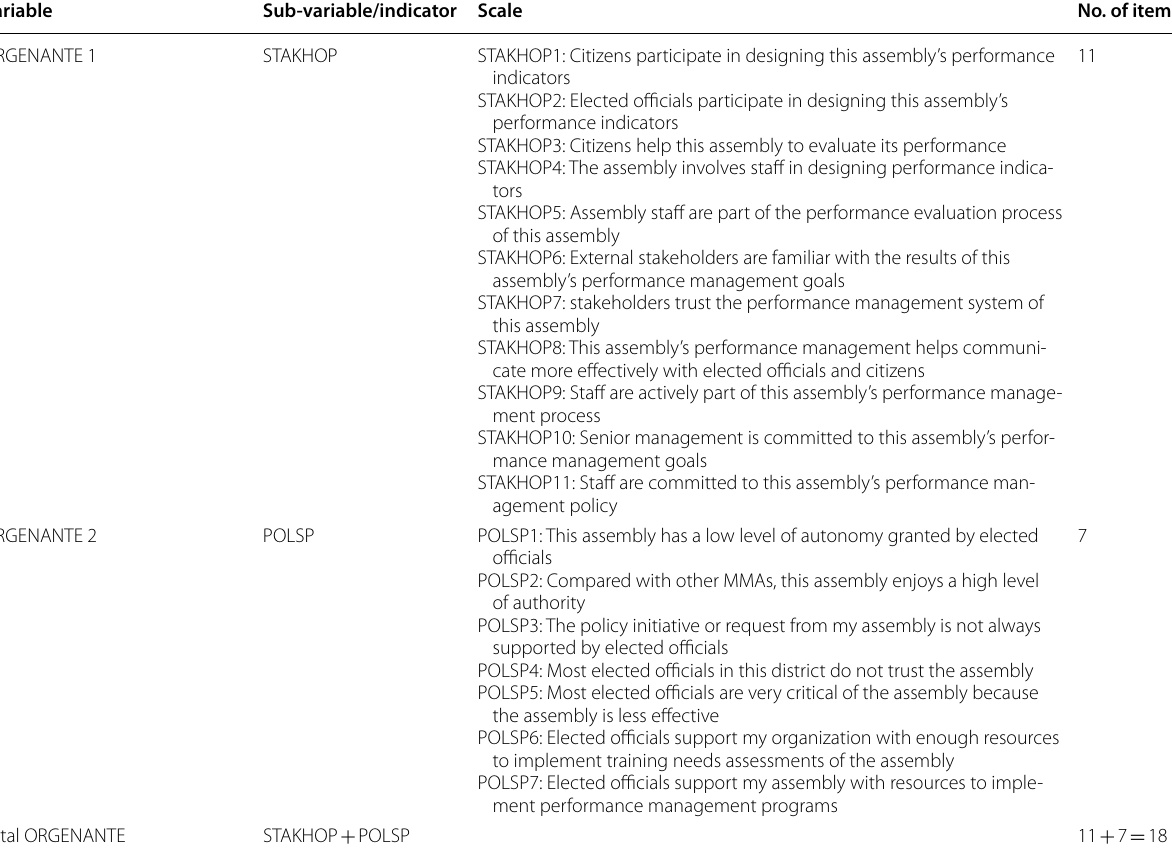
Table 13 Organizational environment antecedents construct